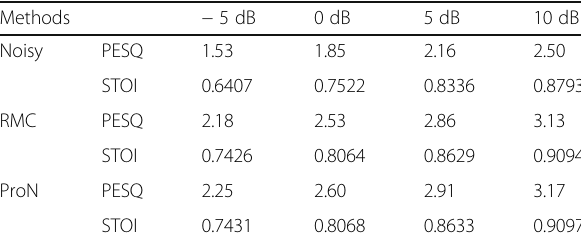
Table 1 Comparison on average STOI and PESQ Methods